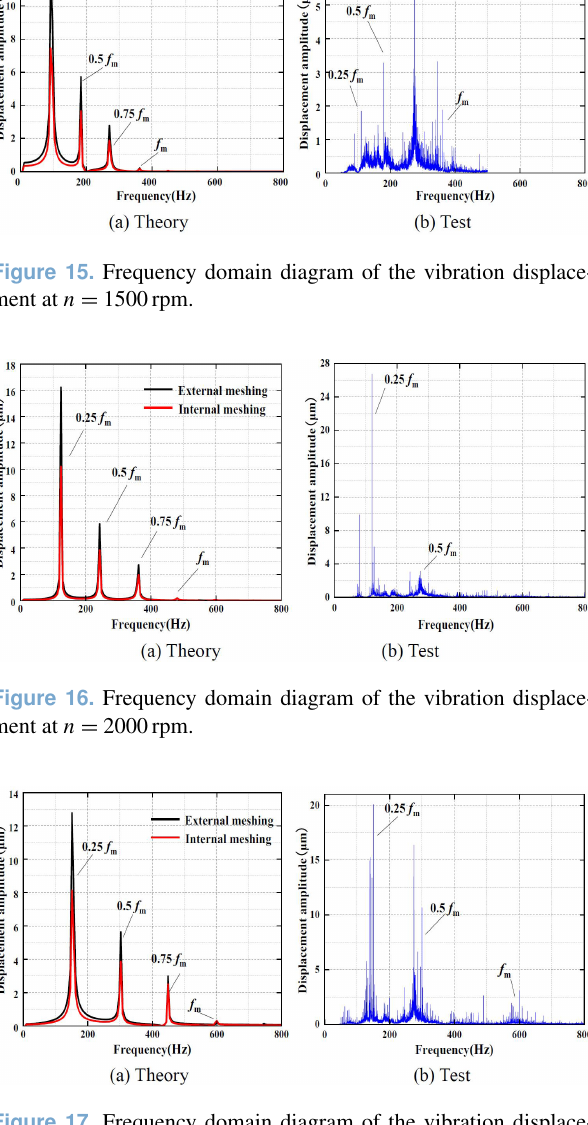
Figure 17. Frequency domain diagram of the vibration displace- ment at n =